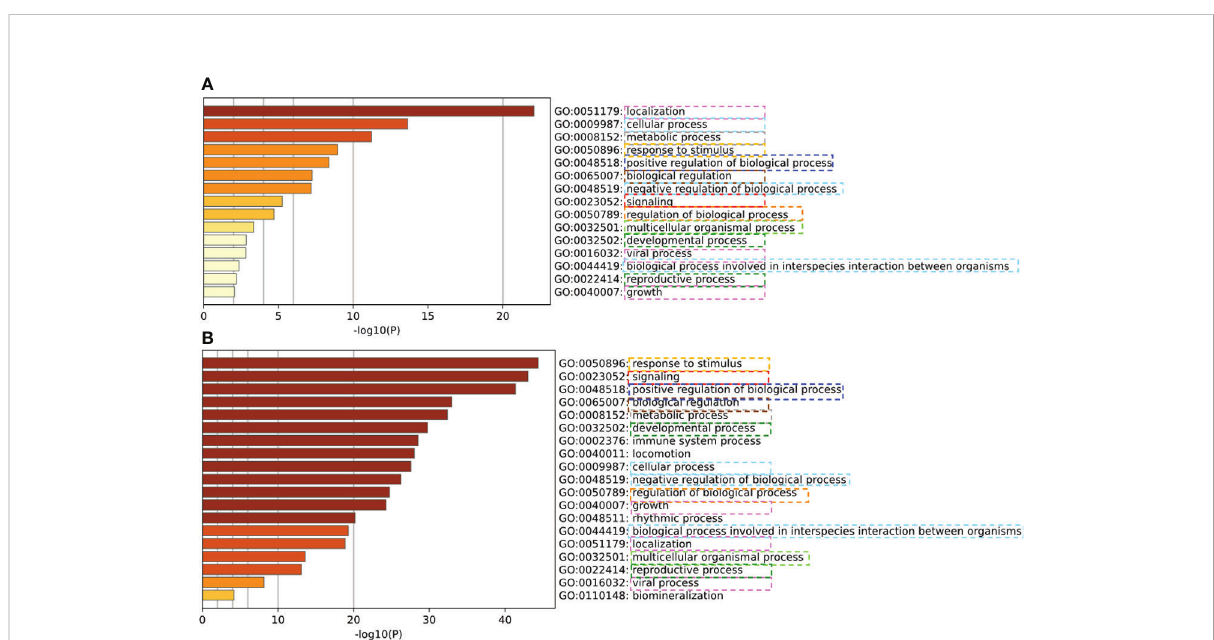
FIGURE 7 Veri fi cation of predicted human-coronavirus protein-protein interactions (PPIs) with experimentally validated PPIs. (A) Enriched GO terms of experimentally validated PPIs. (B) Enriched GO terms of our predicted PPIs. Our predicted PPIs (Figure 6) have coherent informative GO term annotations with the experimentally validated